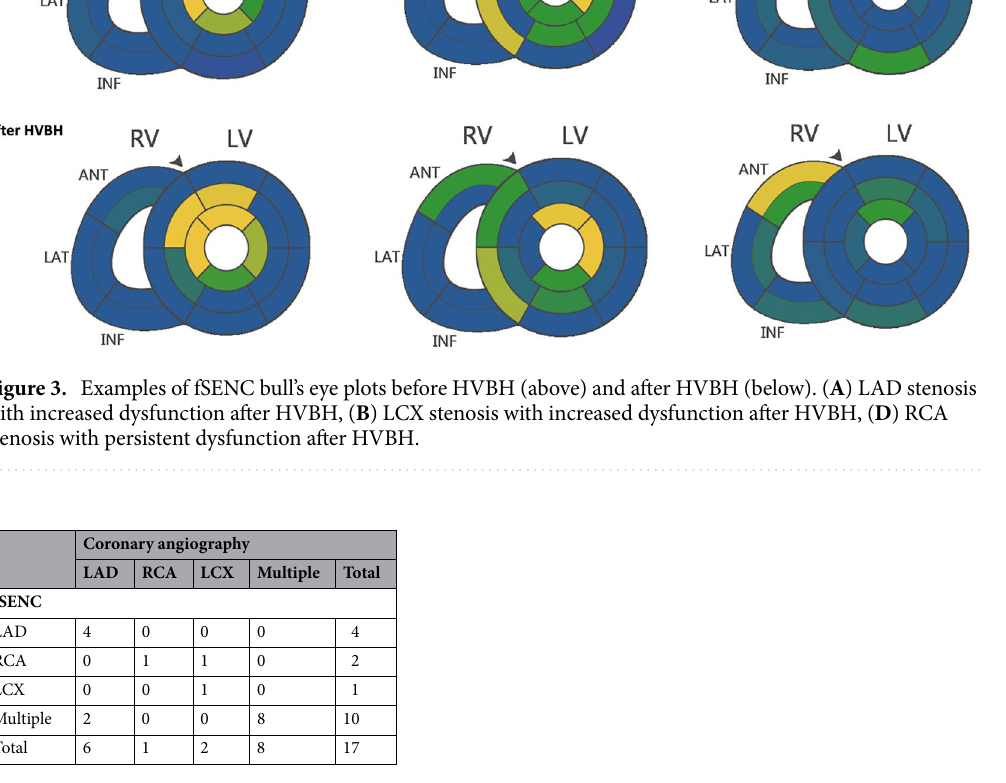
Table 5. Culprit coronary lesions/significant stenoses as identified visually by fSENC bulls-eyes in comparison to coronary angiography results. LAD left anterior descending, RCA right coronary artery, LCX left